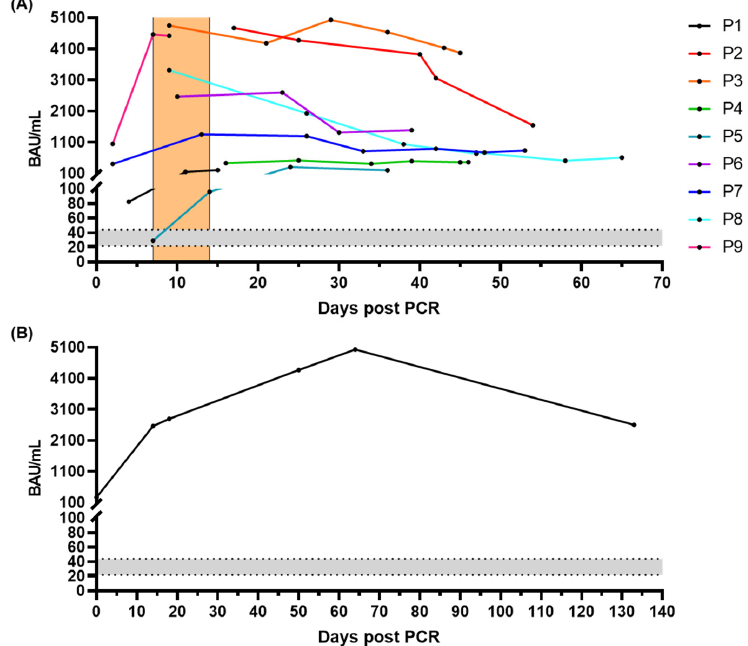
Figure 5. Time course of antibody titers (BAU/mL) during SARS-CoV-2 infection. ( A ) Serum samples collected from nine unvaccinated individual patients. The second week after PCR diagnosis is highlighted in orange. ( B ) DBS samples collected from a patient who was infected six months after the second vaccinations (Pfizer-BioNTech). The grey zone above the cutoff (22 BAU/mL) indicates the range of 22–44 BAU/mL, which is considered as positive.